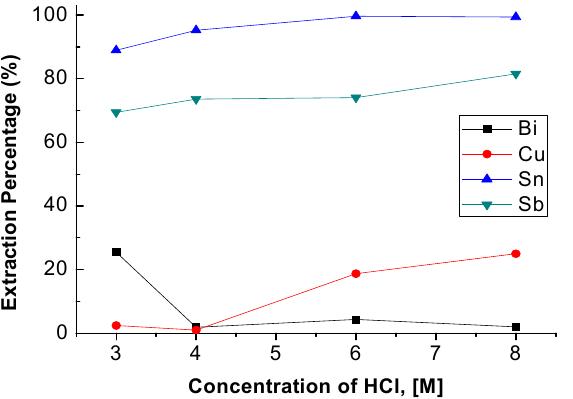
Figure 2. Extraction percentages of metals at different concentrations of HCl. (Tributyl phosphate TBP) = 0.5 M, O/A ratio = 1, reaction time = 5 min.